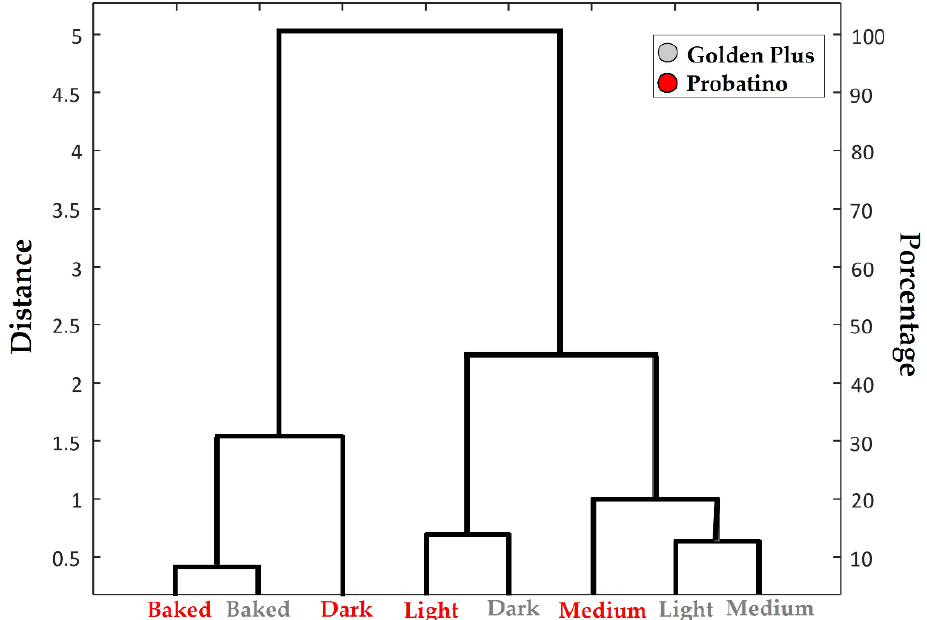
Figure 7. Dendrogram of the eight-point clusters (4 roasting profiles and 2 roasters) in relation to the sensory analysis of roasted coffee samples.